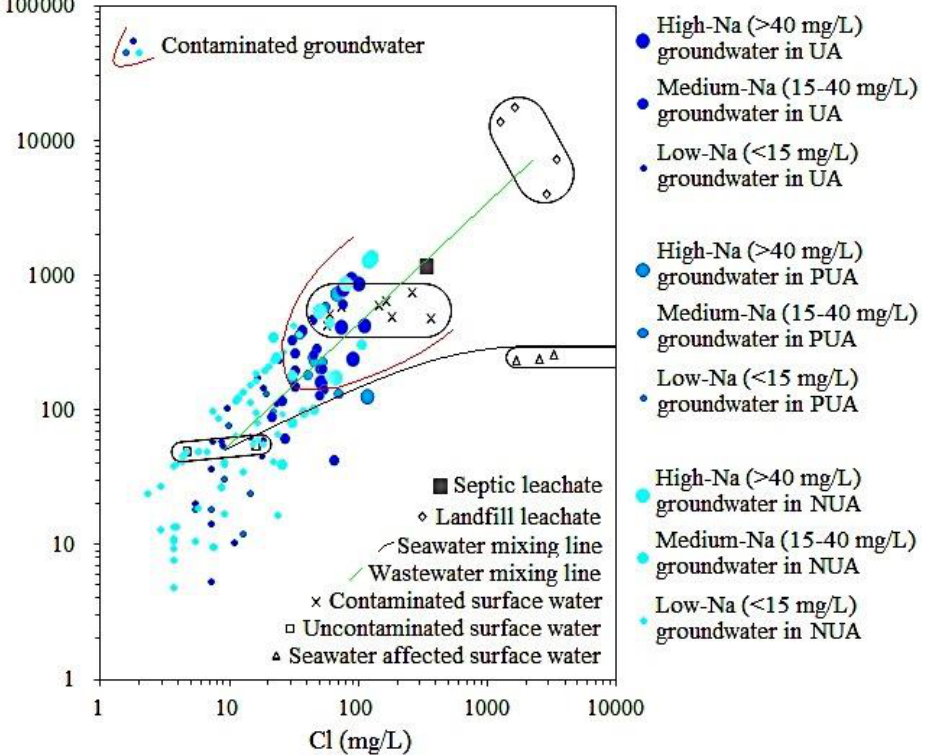
Figure 4. Plot of Cl/Br mass ratios versus Cl concentrations in fissured aquifers in areas with different urbanization levels (UA-urbanized area, PUA-peri-urban area, and NUA-non-urbanized area).